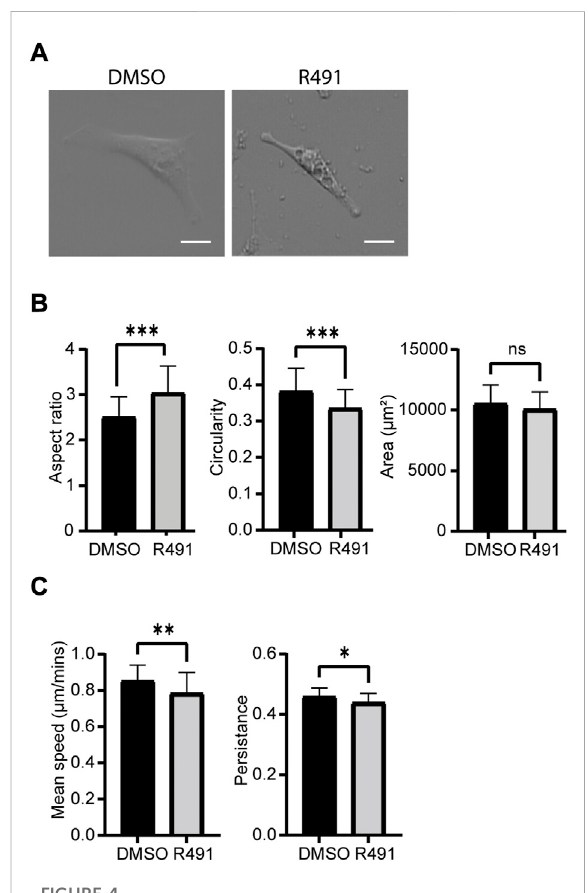
FIGURE 4 R491-treatment decreases the speed and directionality of cell migration and increase cell elongation in BJ-Ras cells. (A) Oblique-contrast images of BJ-Ras-cells treated with control or R491, as indicated, and quanti fi ed with regard to (B) aspect ratio, circularity, spreading area or (C) migration speed and persistence, as indicated. Graphs show means of at least 3biologicalrepeats.Datapresentedasmean±SD.* p ≤ 0.05,** p ≤ 0.01, *** p ≤ 0.001. Scale bars: 50